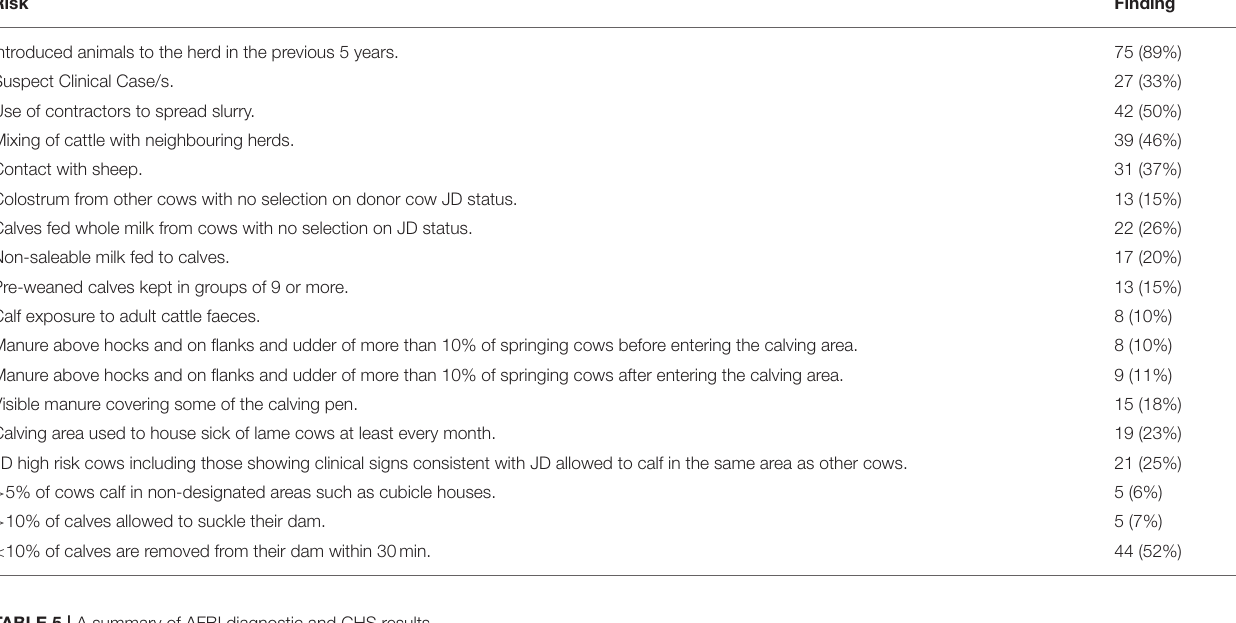
TABLE 4 | Summary of the Johne’s disease risks identified using veterinary risk assessments carried out by AHWNI approved veterinarians from October 2020 To March 2021. Risk Finding Introduced animals to the herd in the previous 5 years. 75 (89%) Suspect Clinical Case/s.